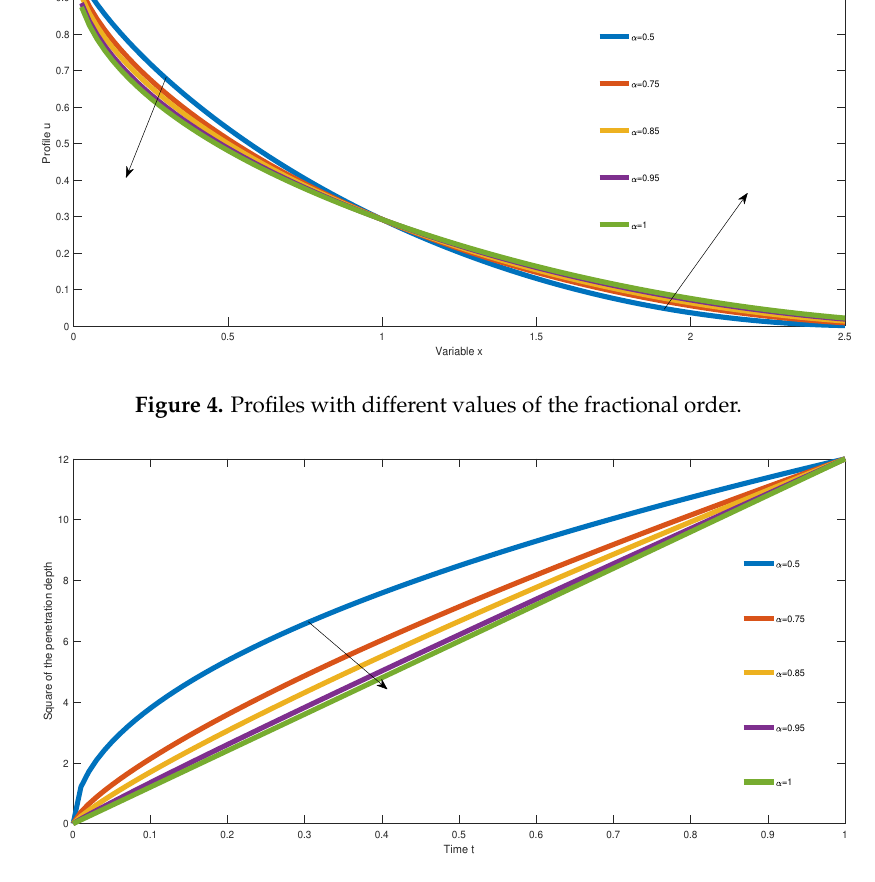
Figure 5. Square penetration depth with different values of the fractional